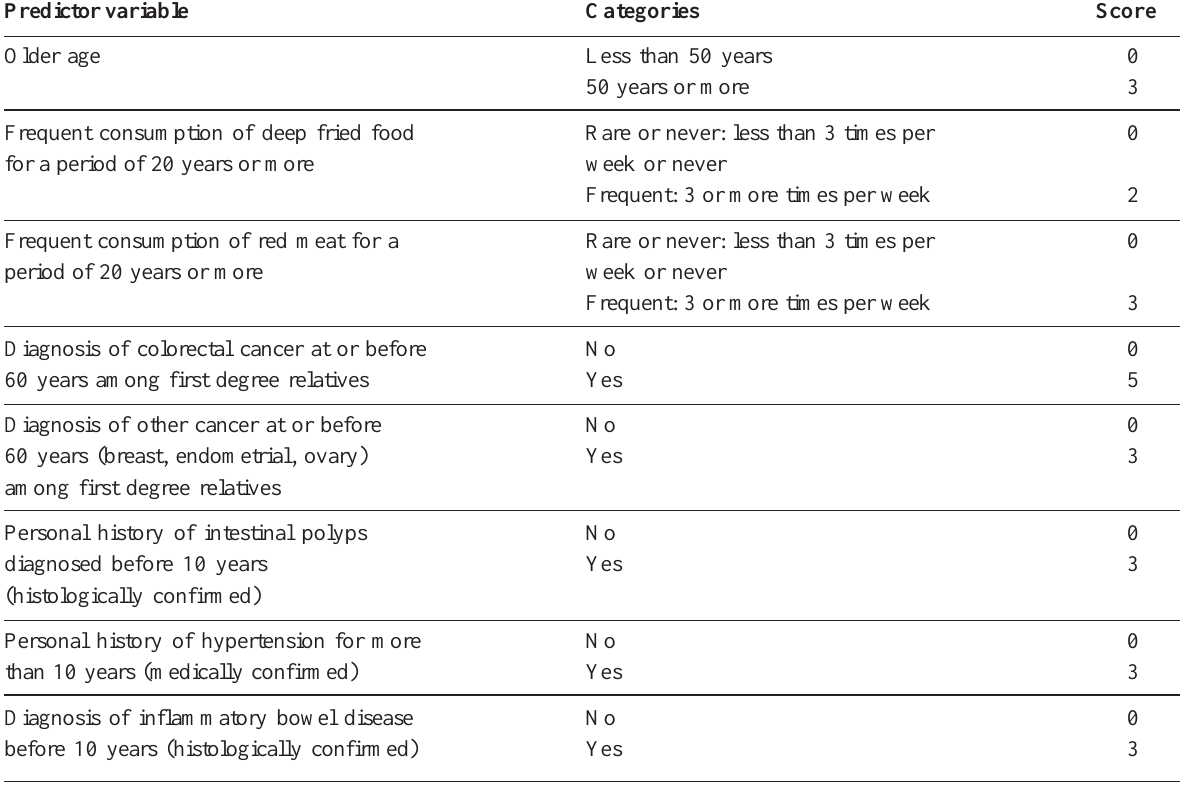
Table 1. Predictor variables included in the risk prediction model for colorectal cancer